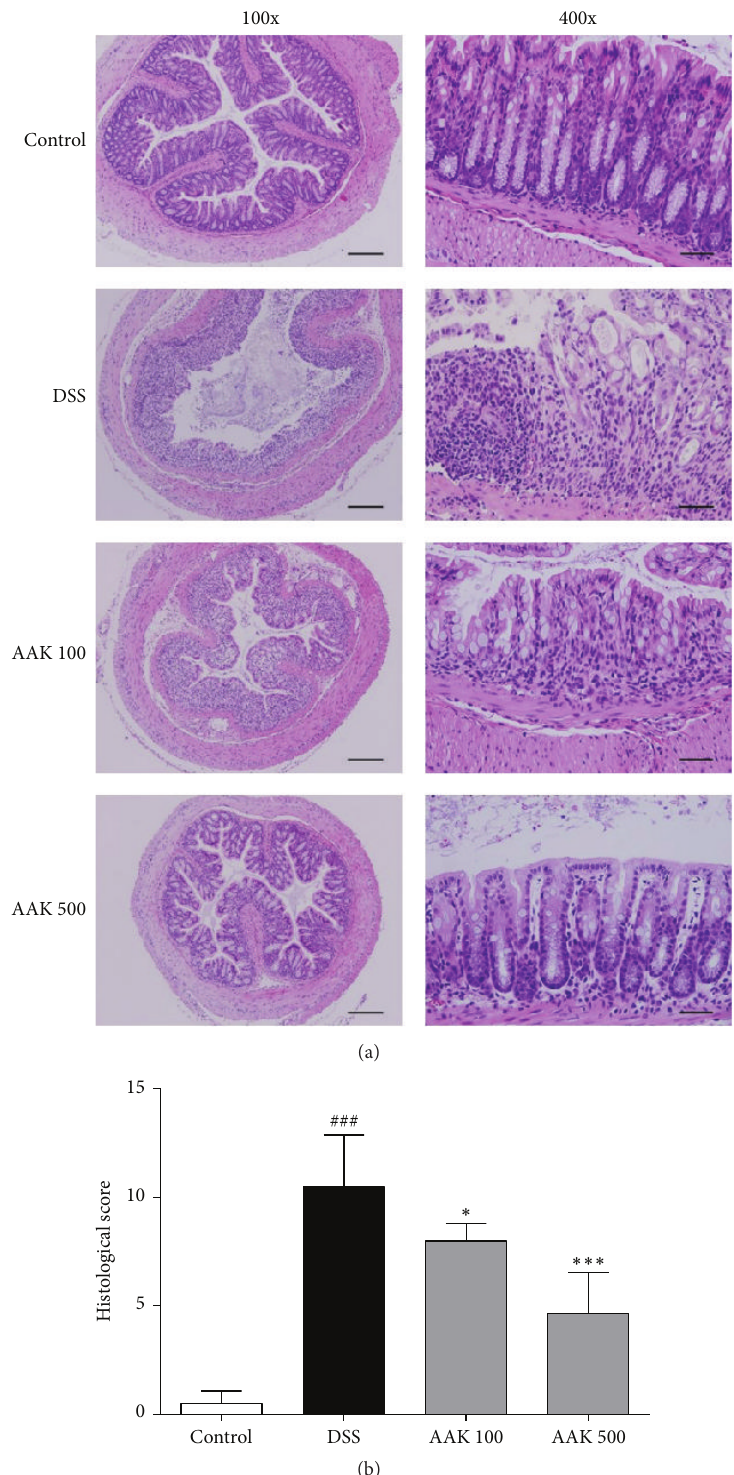
Figure 4: Effects of AAK extract on the colonic histological property of DSS-induced colitis. (a) Representative microscopic images of hematoxylin and eosin (H&E) stained colon sections in each group. Scale bars indicate 400 𝜇 m for transverse sections (100x) and 100 𝜇 m for longitudinal sections (400x). (b) Cumulative histology scores for each group. Data represent the mean ± SD ( 𝑛 = 4 – 6 per group). ### 𝑝 < 0.001 versus control; ∗ 𝑝 < 0.05 and ∗∗∗ 𝑝 < 0.001 versus